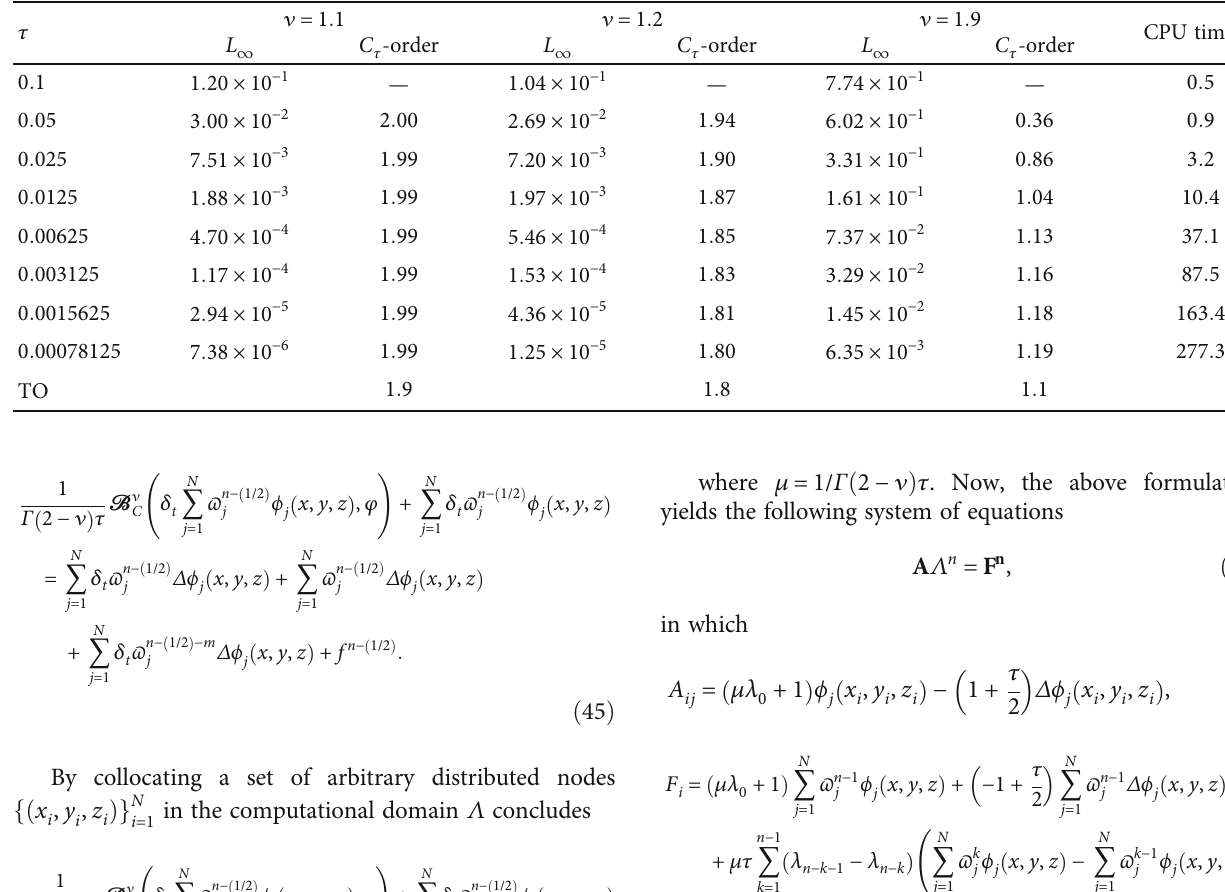
Table 1: Results obtained with 500 collocation points for Example